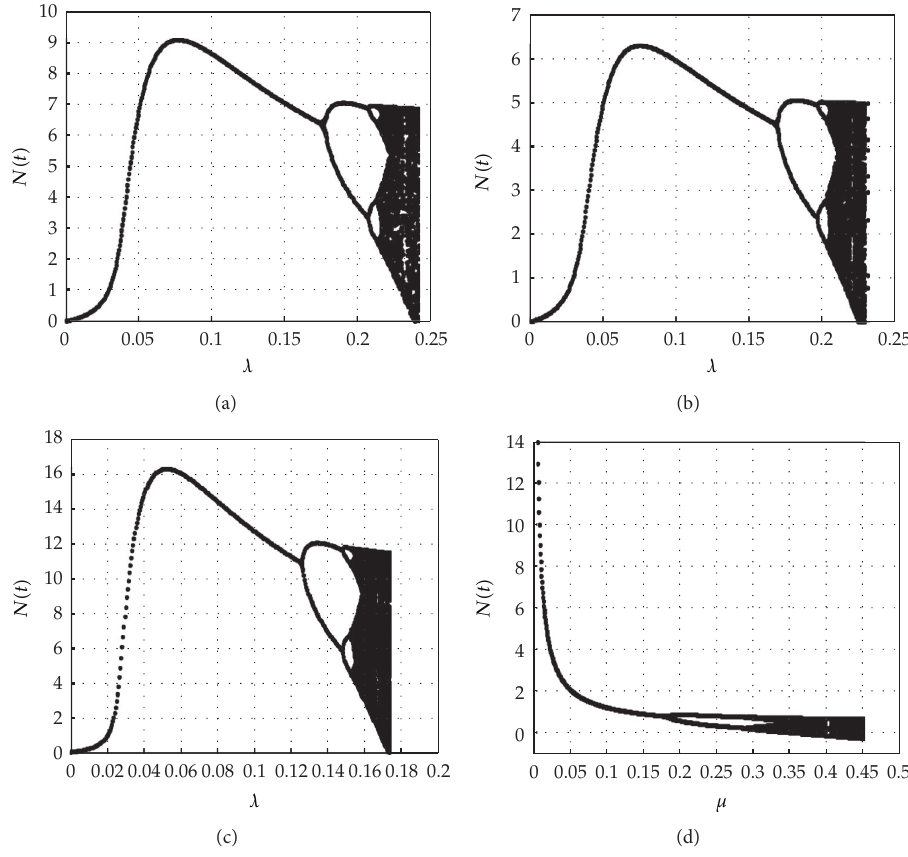
Figure 7: (a) The bifurcation diagram of the process of credit risk contagion with 𝜆 when 𝜇 = 0.01 ; (b) the bifurcation diagram of the process of credit risk contagion with 𝜆 when 𝜇 = 0.015 ; (c) the bifurcation diagram of the process of credit risk contagion with 𝜆 when 𝜇 = 0.01 , 𝜏 = 1.5 ; (d) the bifurcation diagram of the process of credit risk contagion with 𝜇 when 𝜆 = 0.1